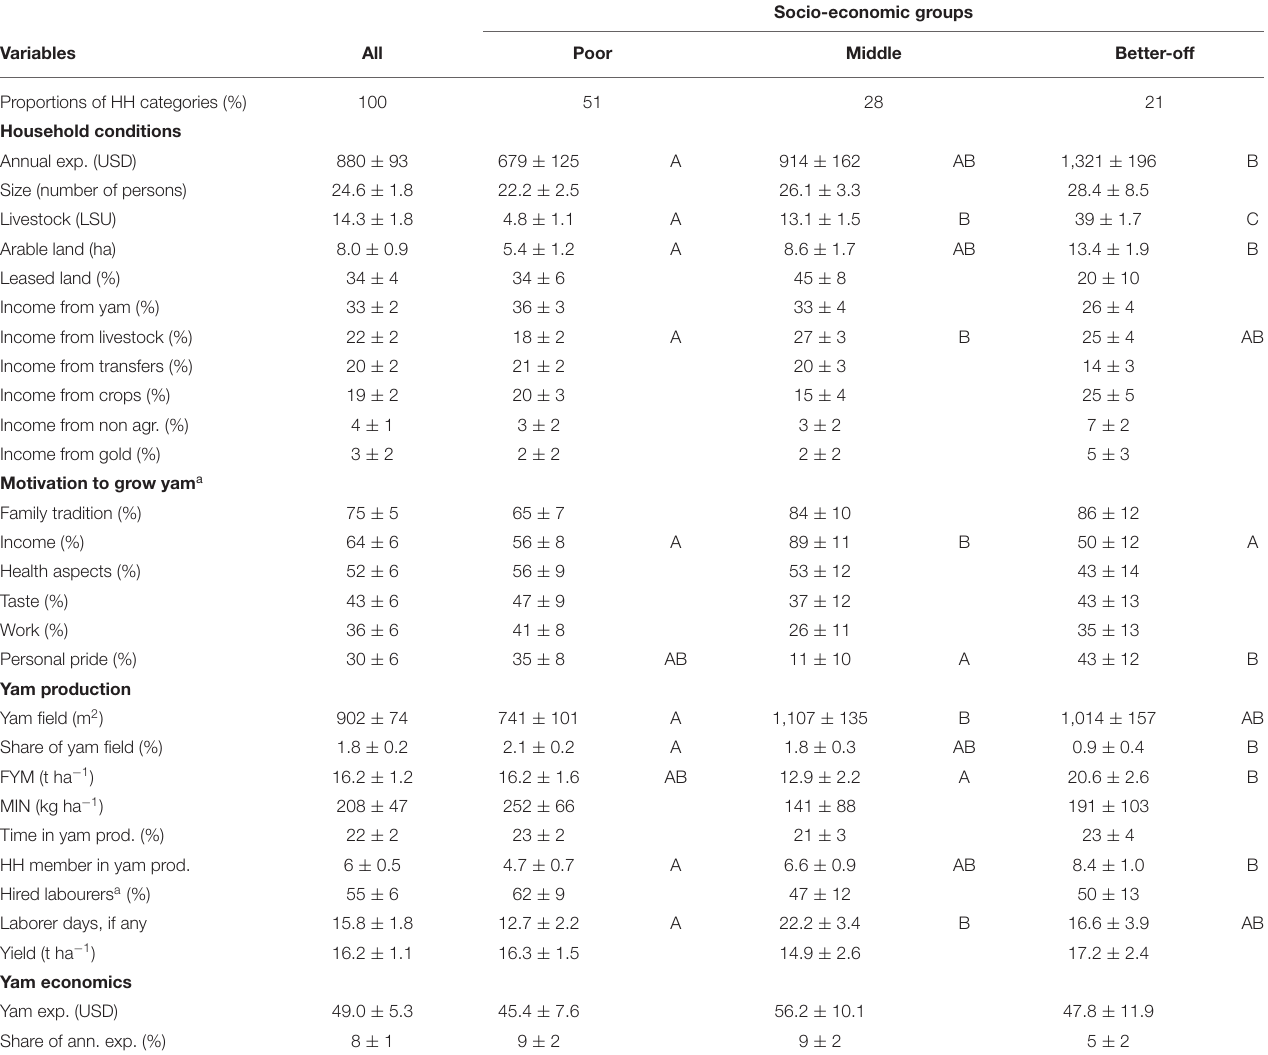
Socio-economic groups